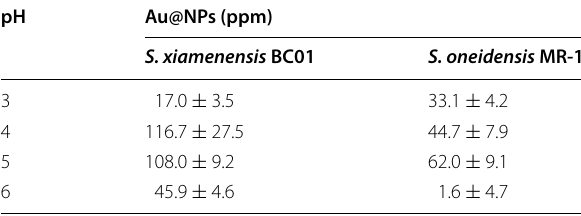
Table 1 The effect of pH on Shewanella at biomass of a